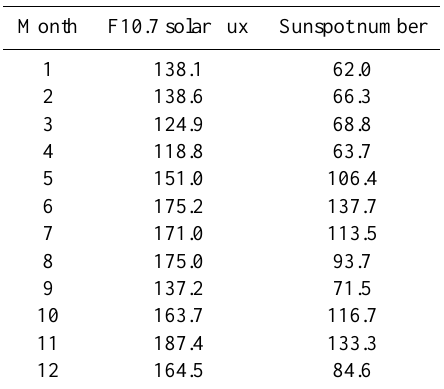
Table 1. Monthly mean values of F10.7 solar flux and sunspot num- ber in